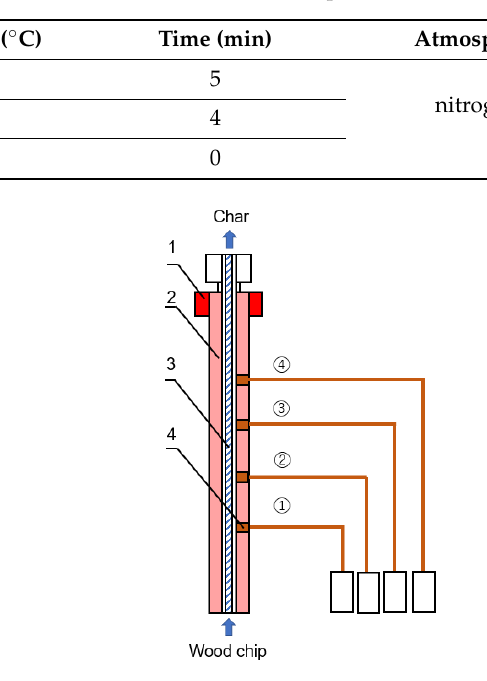
Table 2. Experimental conditions for HTG (group 2).